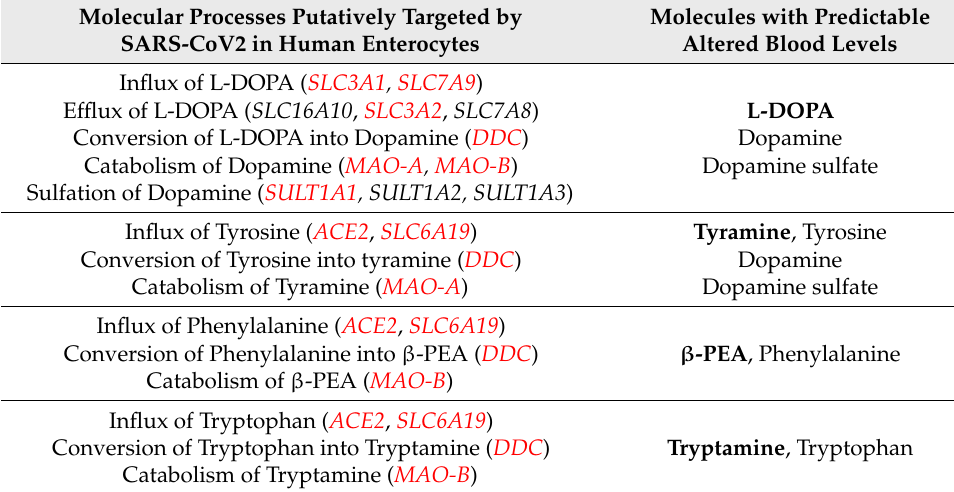
Table 4. Metabolites and neuromediators with predictable altered blood levels in patients with